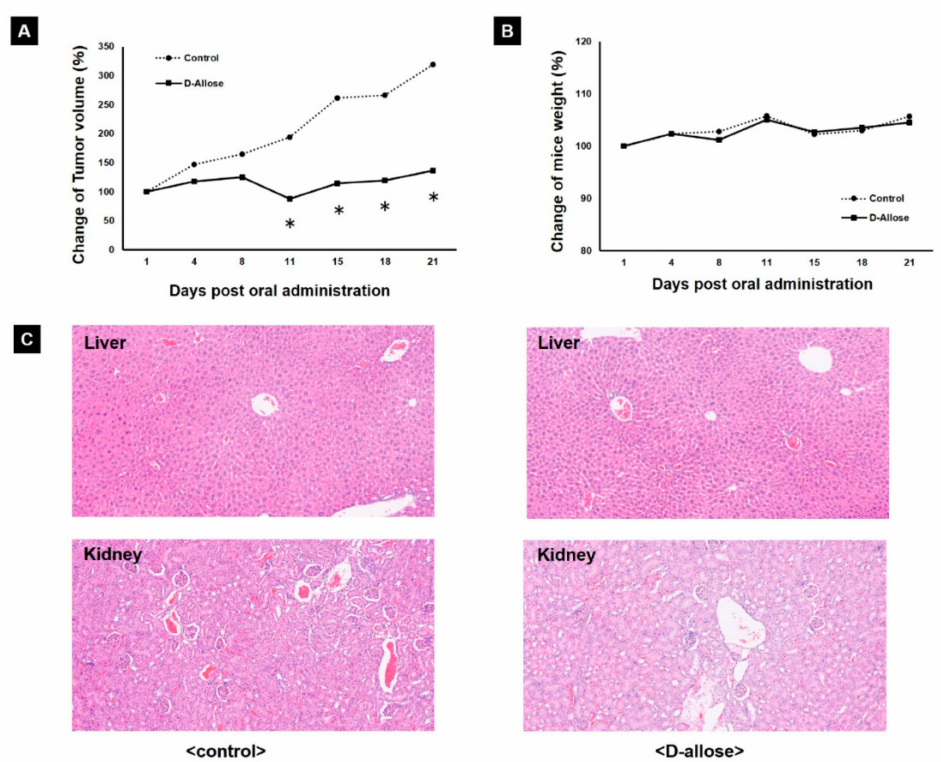
Figure 4. In vivo experiment. ( A ) Oral administration of D-allose inhibited tumor growth in vivo in mouse xenografts. RT112 tumors, treated with oral administration of D-allose or normal saline, were enucleated 20 days after treatment initiation. Statistically significant ( p < 0.05) decreases in tumor volume compared with the control (set at 100%) are represented by asterisks (*). ( B ) Mouse xenografts treated with oral D-allose showed no significant difference in body weight from that in the control (normal saline). ( C ) There was no difference in the histological findings of the kidneys or livers between mice treated with oral administration of D-allose and those treated with normal